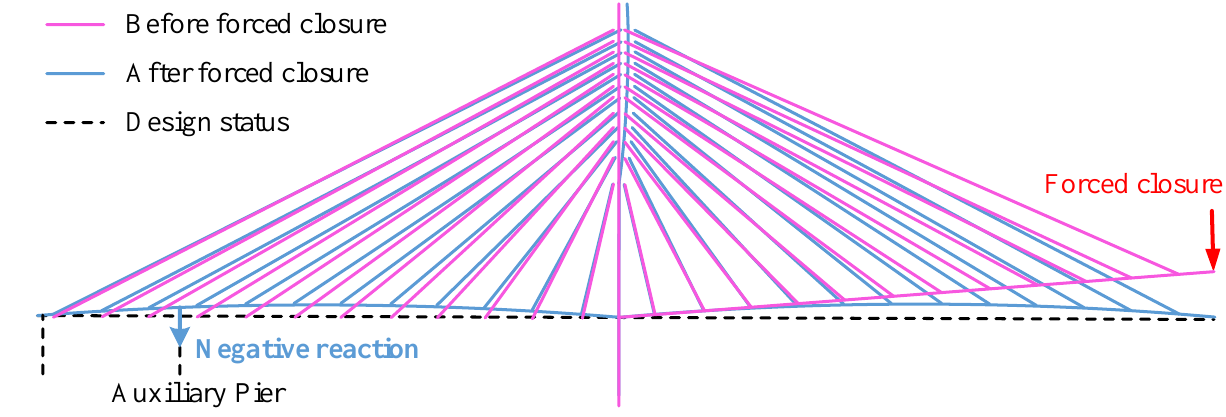
Figure 3. NRRAP caused by forced closure.